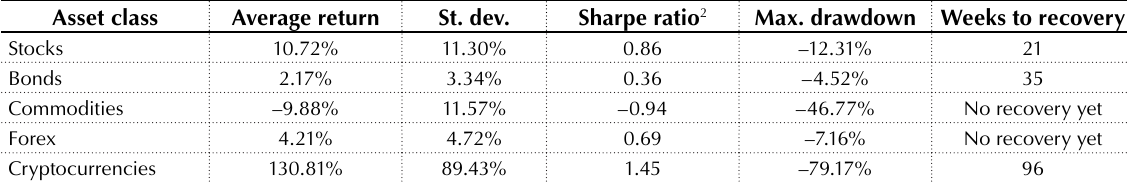
Table 3. Annual risk/return profiles of established asset classes and cryptocurrencies, period from